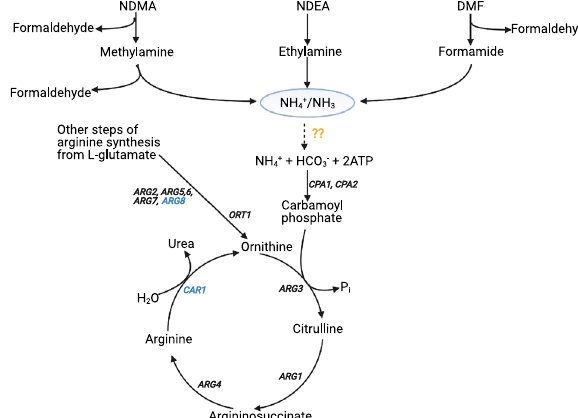
Figure 5. Relationship between nitrosamine/DMF degradation and arginine metabolism as observed in our experiments. Genes labelled in black correspond to deletion strains that displayed growth defects in our experiments, while those in blue did not show fitness defects. The dashed arrow with question marks (in yellow) means the reaction is hypothetical, i.e. depicting NH 4 from nitrosamine degradation entering the arginine biosynthetic pathway. In the diagram, only metabolic intermediates of nitrosamine/DMF that we screened are